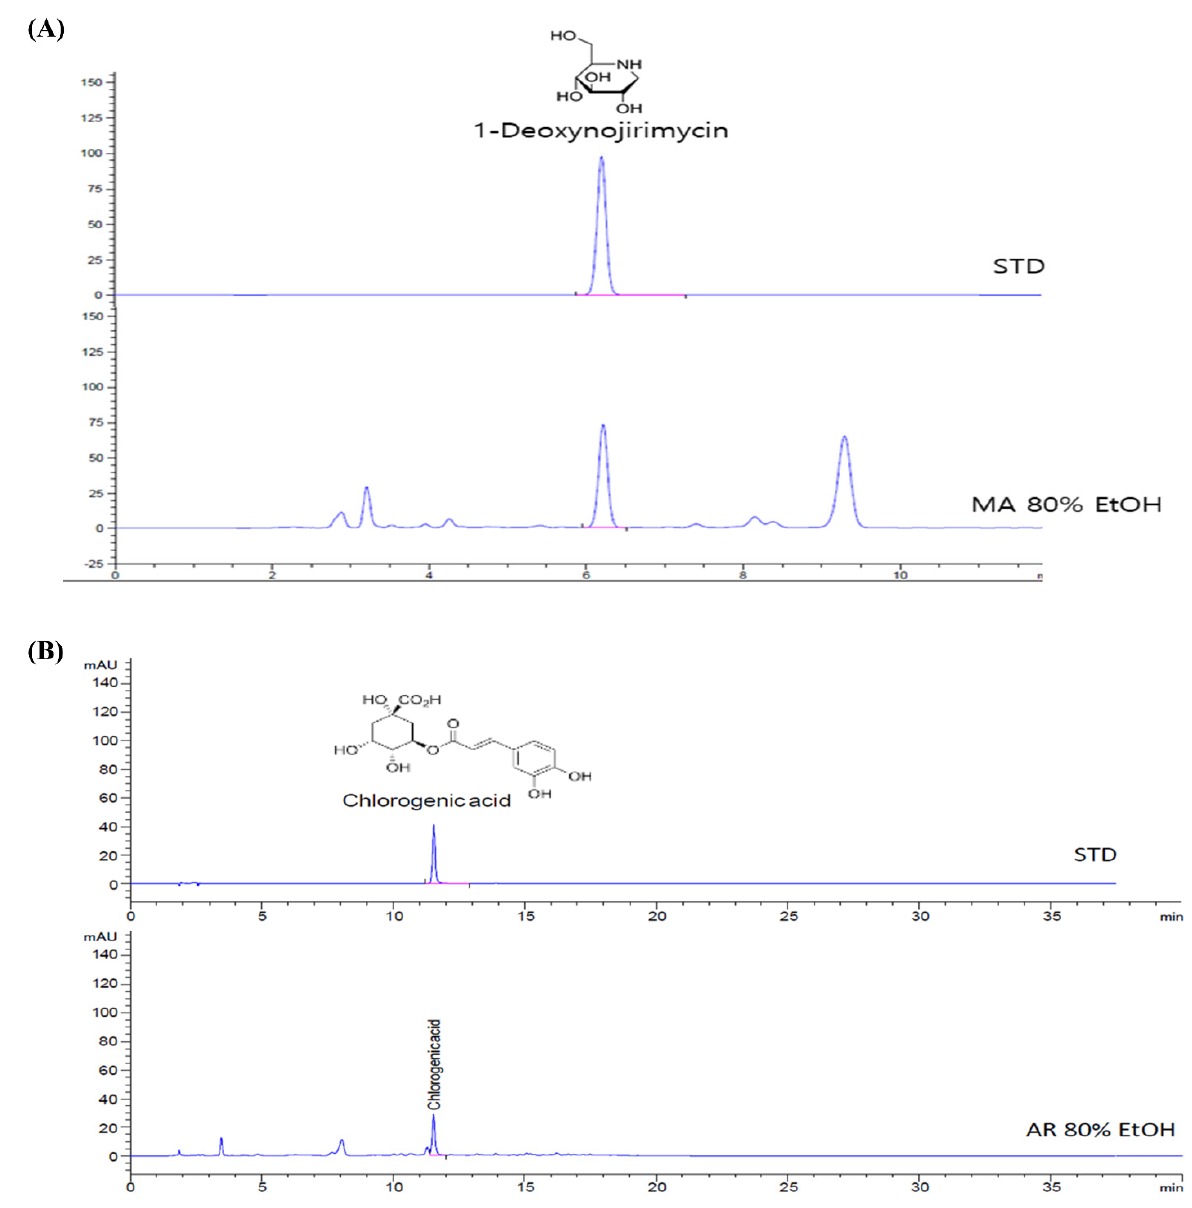
Figure 1. HPLC analysis of Morus alba (MA) leaf and Aronia melanocarpa (AR) fruit and chemical structure. ( A ) HPLC chromatogram of MA extract, ( B ) HPLC chromatogram of AR extract.